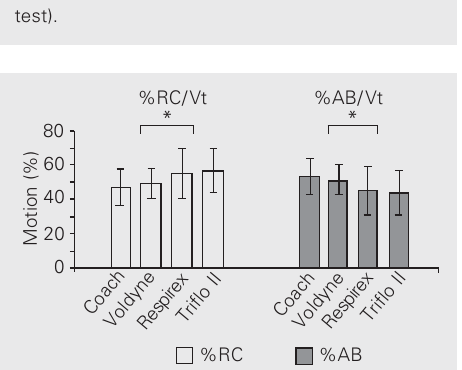
Figure 1. Contribution of rib cage motion to tidal volume (%RC/Vt) and contribution of abdominal motion to tidal volume (%AB/ Vt). Data of